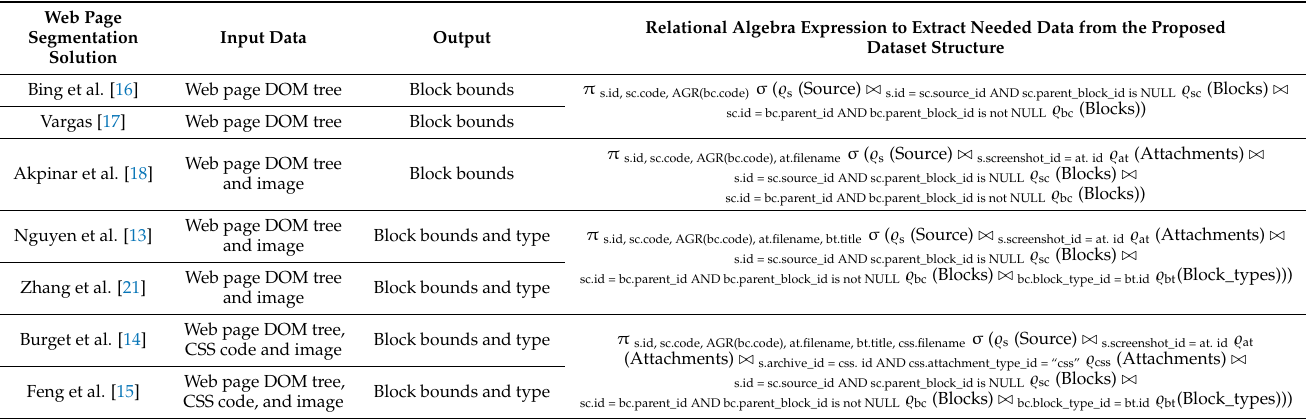
Table 2. Proposed dataset suitability for existing web page segmentation and labeling